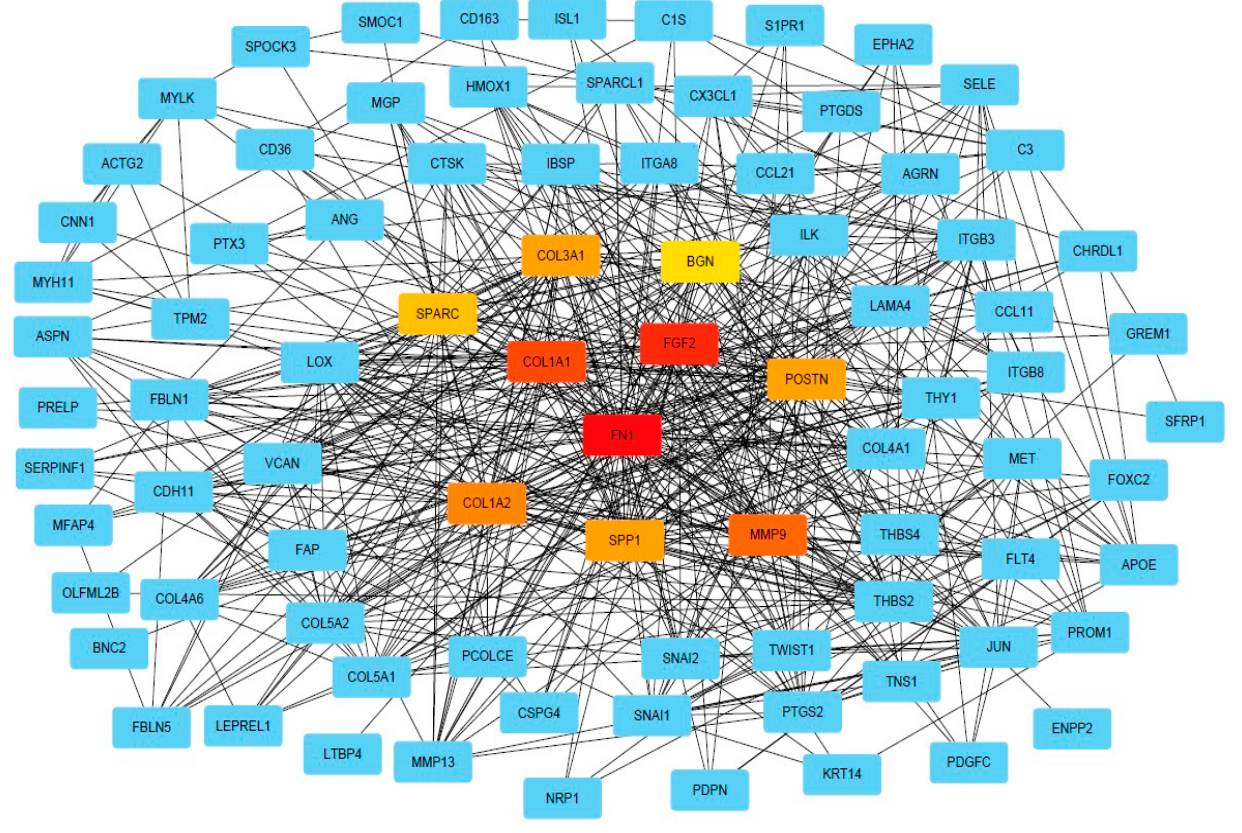
Figure 4. PPI network of DEGs. PPI network of DEGs analysis provided by String (string-db.org) and Cytoscape (Cytoscape.org), squares indicate DEGs, and lines indicate interactions. The intensity in red of the squares indicates the degree of global network interactions.